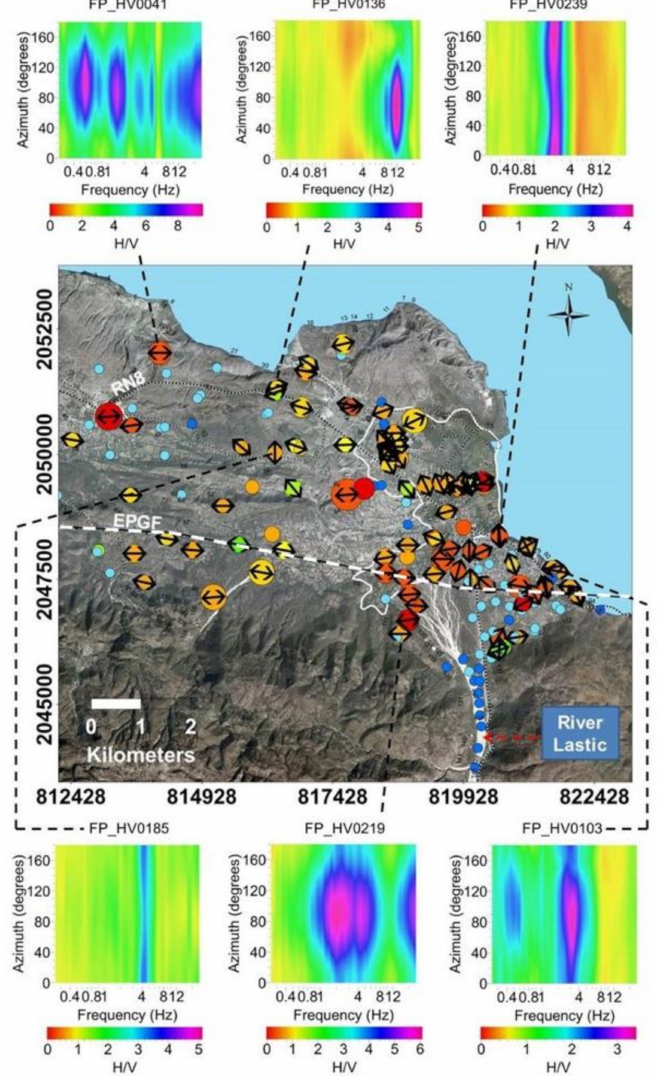
Figure 8. Azimuth analysis of the HVSR measurements performed in Fond Parisien. Graphs on top and at the bottom show the amplitude distribution over frequency and azimuth for six measurements. The double arrow on top of the f0-amplitude circles (see legend in the previous Figure 7) represents the preferential shaking orientation (of ambient